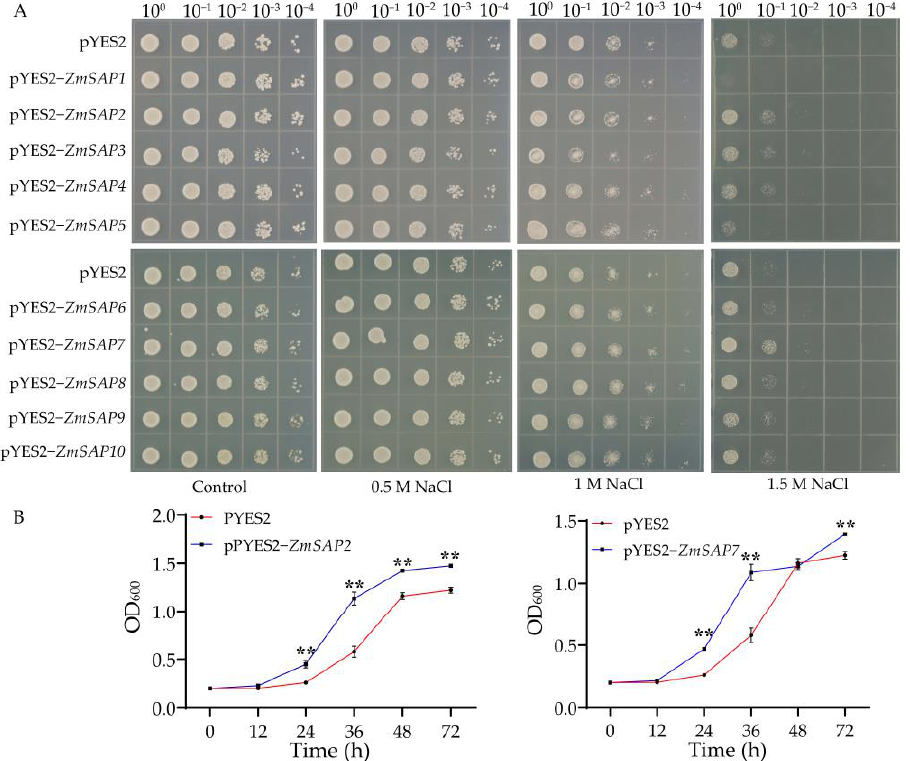
Figure 9. The phenotype of yeast cells carrying ZmSAP genes under salt stress by NaCl treatment. ( A ) The phenotype of all yeast strains on solid YNB-Ura-Gal 2% medium without (control) or with 0.5, 1.0 and 1.5 M NaCl. Photographs were taken after four days of incubation at 28 °C. ( B ) The growth curve of yeast cells expressing pYES2, pYES2- ZmSAP2 and pYES2- ZmSAP7 plasmid in YNB-Ura-Gal 2% liquid medium supplemented with 1.5 M NaCl for three days at 28 °C with an initial OD 600 = 0.2, respectively. **, indicates significant differences at p < 0.01.